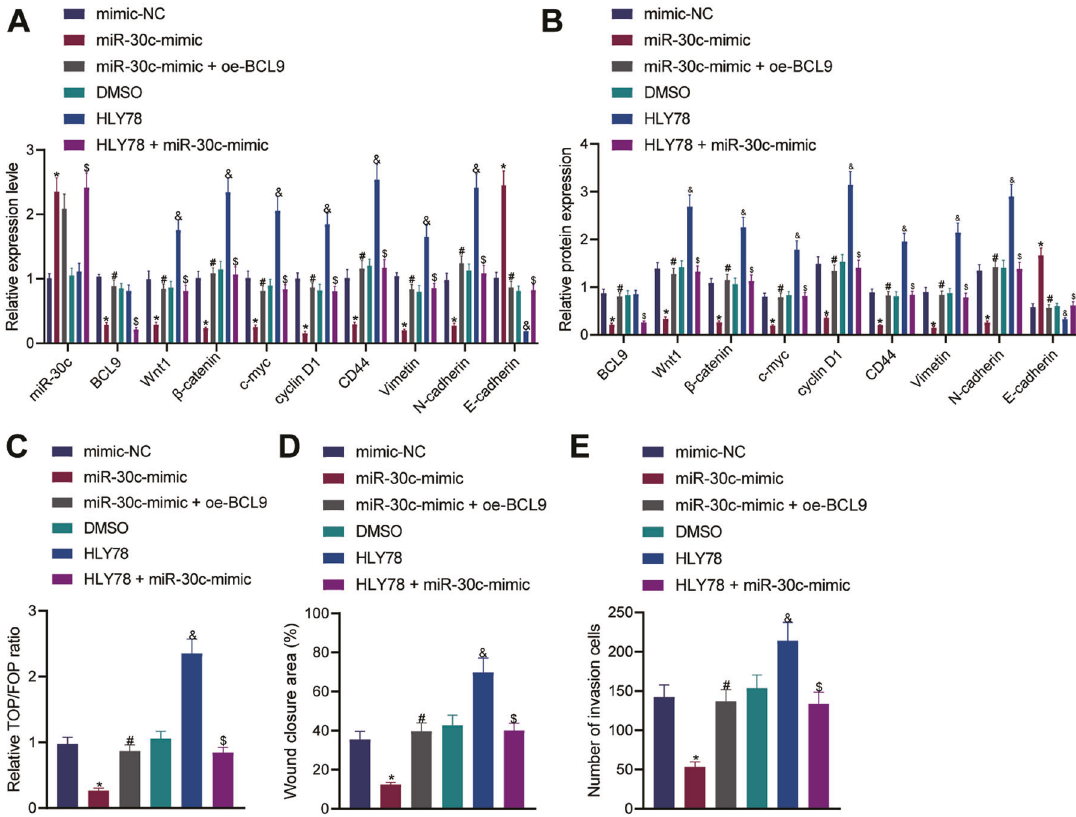
Fig. 4 miR-30c attenuated the invasion and migration of ecto-EECs through the BCL9/Wnt/CD44 regulatory cascade. A qRT-PCR measurement of the expression of related genes in ecto-EECs of each group; B Western blot measurement of the protein expression of related factors in ecto-EECs of each group; C Dual-luciferase reporter assay to detect the Wnt gene activity, as re fl ected by the TOP/FOP ratio, in ecto- EECs of each group; D Wound healing assay to detect cell migration in ecto-EECs of each group; E Transwell assay to detect cell invasion in ecto-EECs of each group. Cellular experiments were repeated three times. Measurement data were characterized as mean ± SD. The comparison among data of multiple groups was performed with one-way ANOVA with Tukey ’ s post hoc test. * p < 0.05 versus the mimic-NC group; # p < 0.05 versus the miR-30c-mimic group; & p < 0.05 versus the DMSO group; $ p < 0.05 versus the HLY78